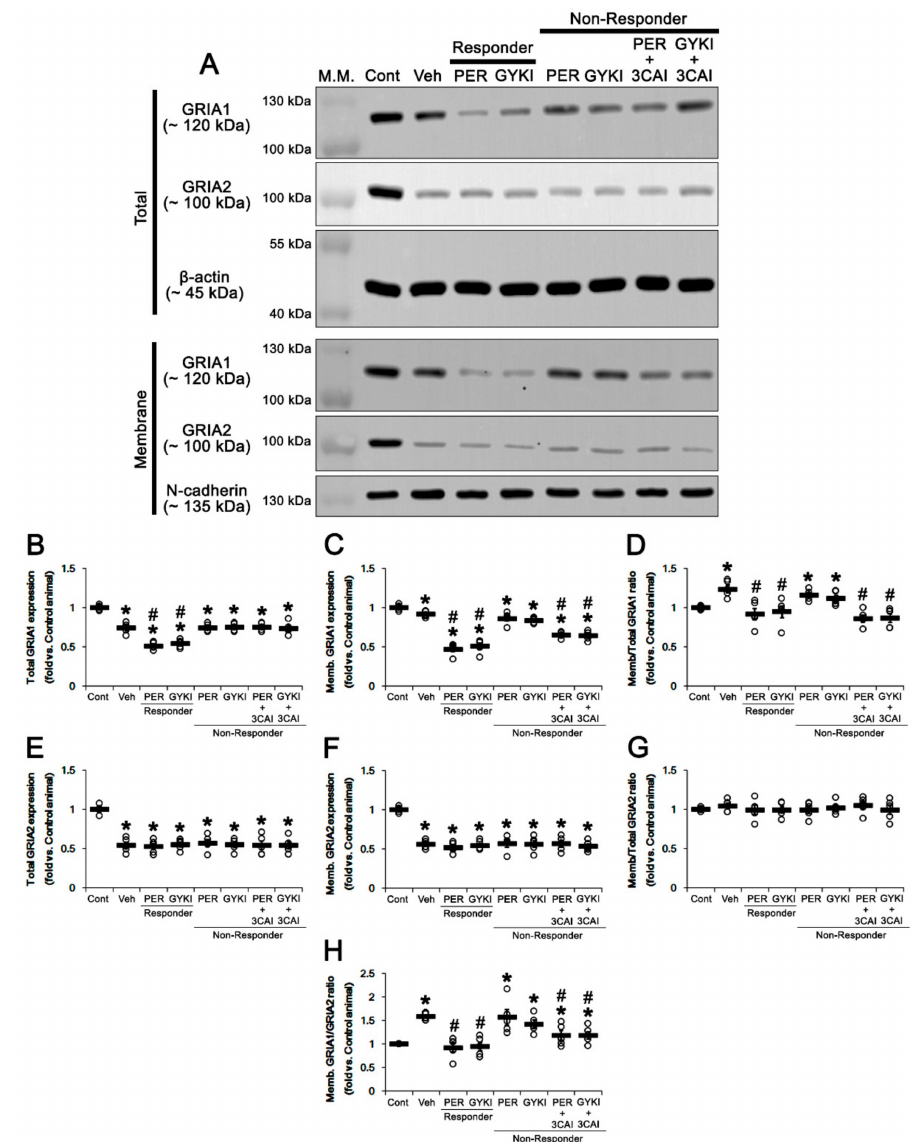
Figure 10. The effects of 3CAI co-treatment with perampanel (PER) and GYKI 52466 (GYKI) on surface expressions of GRIA1 and GRIA2 in chronic epilepsy rats. ( A ) Representative images for Western blot of total and membrane GRIA1 and GRIA2 expression levels. ( B – H ) Quantifications of total GRIA1 expression ( B ), membrane GRIA1 expression ( C ), membrane/total GRIA1 ratio ( D ), total GRIA2 expression ( E ), membrane GRIA2 expression ( F ), membrane/total GRIA2 ratio ( G ), and membrane GRIA1/GRIA2 ratio in the hippocampal tissues. Open circles indicate each individual value. Horizontal bars indicate mean value. Error bars indicate SEM ( *, # p < 0.05 vs. control (Cont) and vehicle (Veh)-treated animals, respectively; one-way ANOVA with post hoc Bonferroni’s multiple